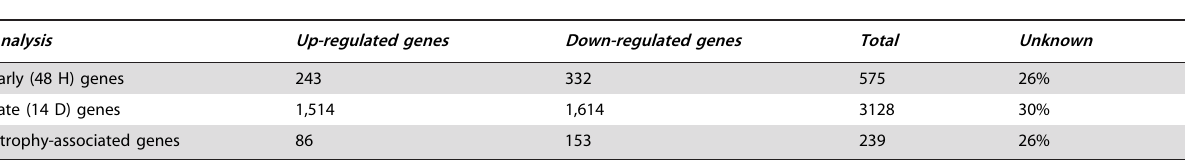
Table 2. Summary of micro-array